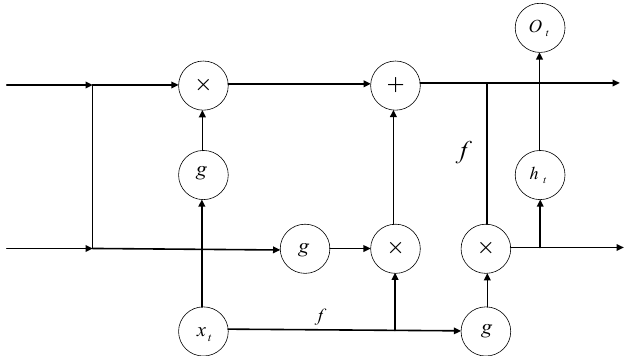
Figure 7. LSTM hidden layer structure diagram.